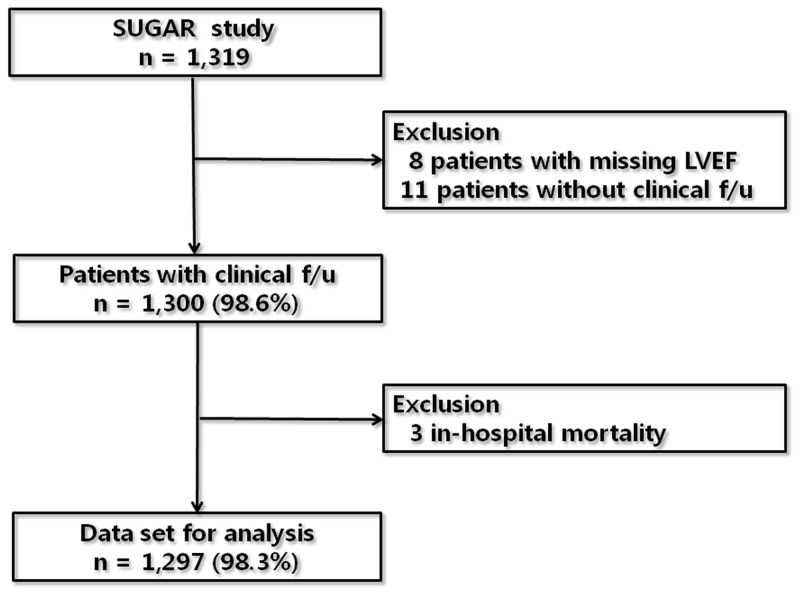
Dataset for the study population.LVEF, left ventricular ejection fraction; f/u, follow-up.